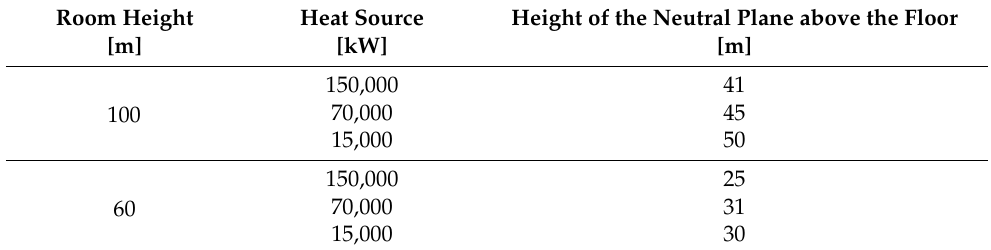
Table 1. The neutral plane position depending on the heat source and room